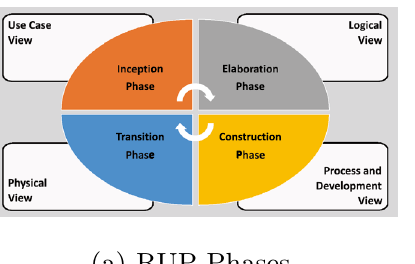
Fig. 6 The software develop- ment life cycle process of the stereo vision system is based on a combination of the RUP and the 4+1 view architectural